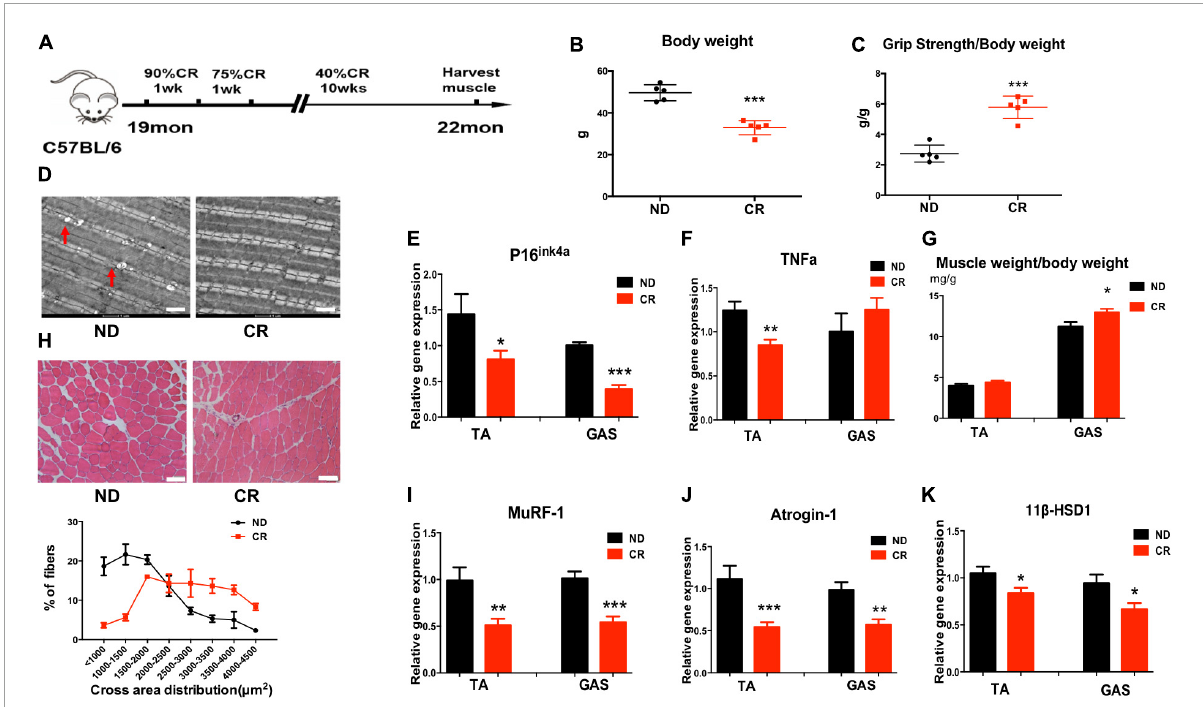
FIGURE2 Calorie restriction (CR) improves muscle atrophy and muscle function in aged mice by reducing 11 β -HSD1. (A) CR was initiated in mice at 19 months of age and continued for 3 months to 22 months of age. (B) Body weight of CR mice and normal diet (ND) mice ( n = 5 mice per group). (C) Muscle strength of CR mice and ND mice ( n = 5 mice per group). (D) Representative images using electron microscopy for vastus lateralis muscles from ND and CR mice. Scale bars, 2 µ m. (E,F) mRNA quantification of the senescence marker gene p16 ink4a and the inflammation gene TNF α . (G) Muscle weight/body weight in CR and ND mice ( n = 5 mice per group). (H) Representative HE staining images of muscle cross sections derived from CR and ND mice. Scale bars, 50 µ m. Percentage distribution of muscle fiber cross-sectional area